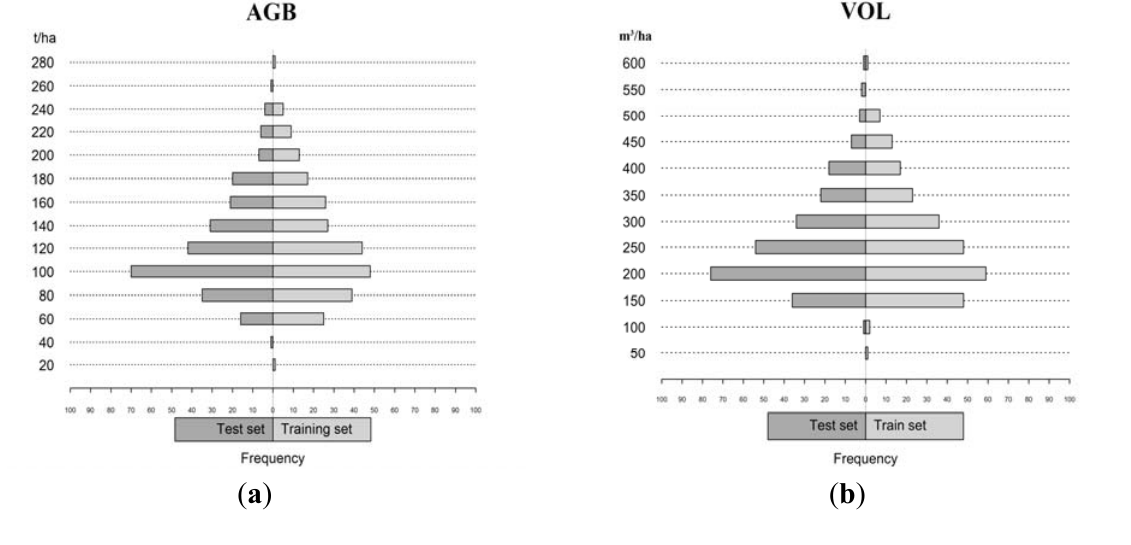
Figure 1. ( a ) AGB and ( b ) VOL frequency distributions for test and training sets with class interval of 20 t/ha (AGB) and 50 m 3 /ha (VOL).